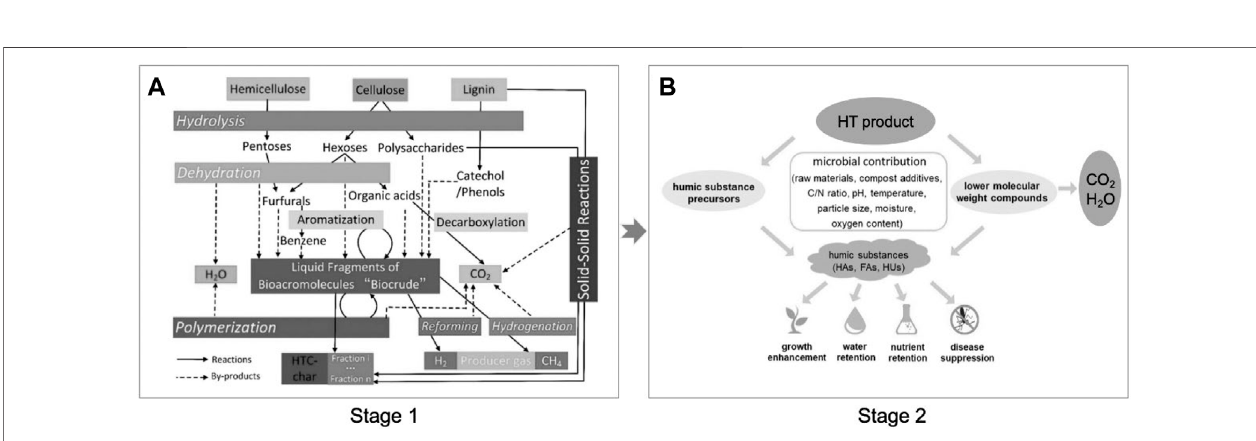
FIGURE5| Schematicdiagramofthecombinationprocessofhydrothermaltreatment(stage1)withcomposting(stage2). (A) ReproducedfromtheworkbyKruse et al. (2013) with permission from Elsevier, copyright 2013; (B) reproduced from the work by Guo et al. (2019) with permission from Elsevier, copyright 2019.